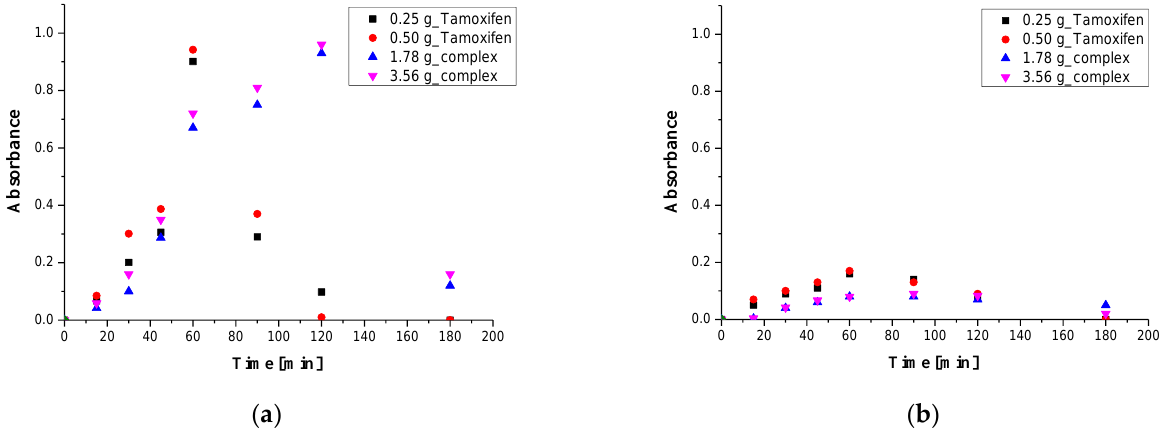
Figure 12. Results of release studies of tamoxifen from the composites in an acidic environment ( a ) and alkaline environment ( b ).